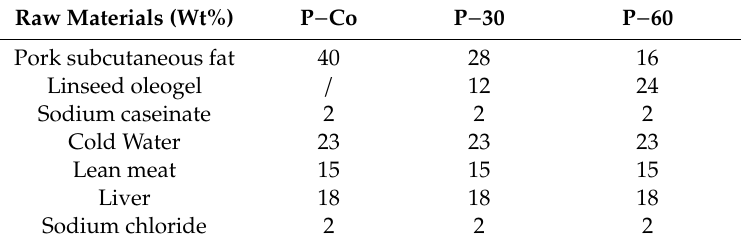
Table 5. pH and chemical composition of all sets of pasteurized p â t é samples; (P-CO: control sample; P-30 and P-60: samples with 30% and 60% of pork fat replacement, respectively).